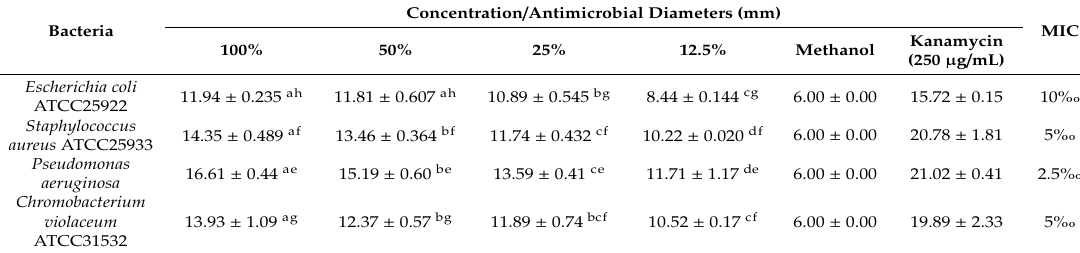
Table 2. Antibacterial e ff ect of C. camphora EO.